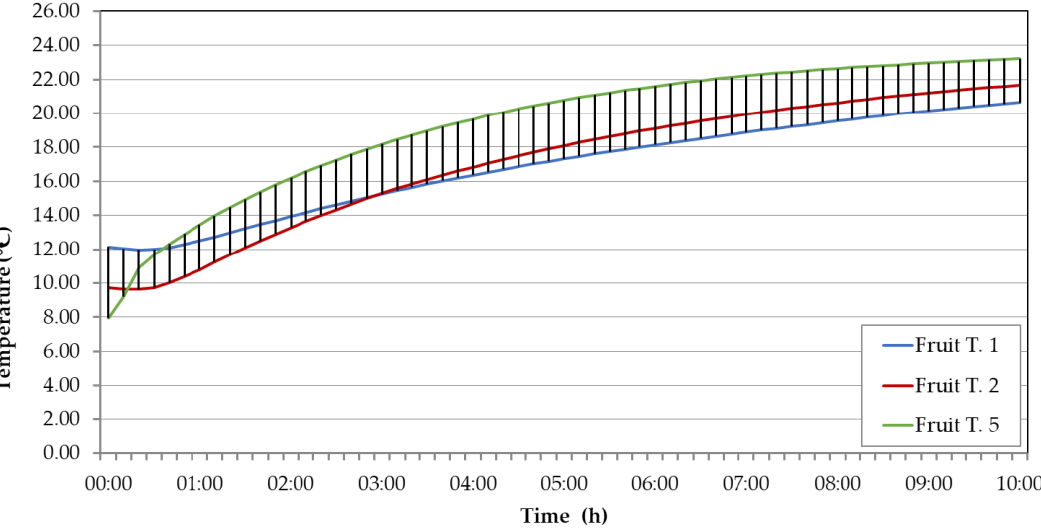
Figure 10. Thermal behavior of configuration B, packages 1 to 3, for the heating process.